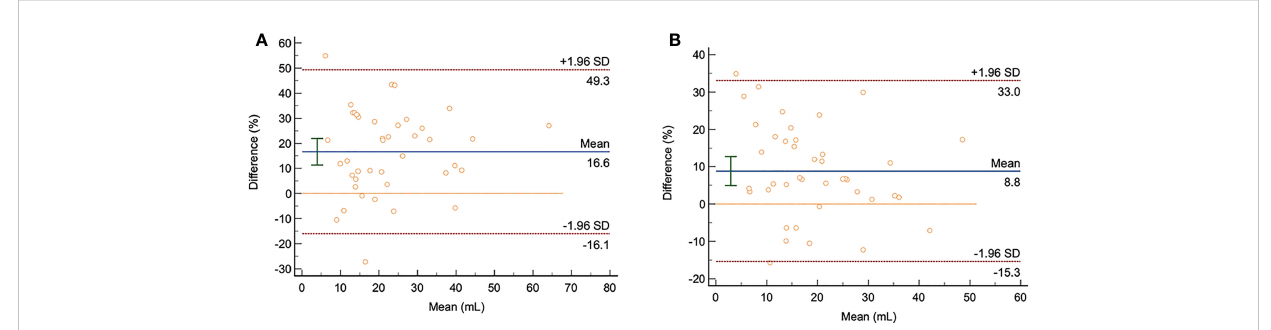
FIGURE 3 The Bland-Altman analysis chart of the semi-automatic and manual delineation for measuring GTV on the DWI images with b= 1000 s/mm 2 and b= 1500 s/mm 2 (n=41). (A, B) : The consistency analysis of GTV measurement by radiologist 1 using manual delineation and semi-automatic delineation with 30% as thresholds on the DWI images with b= 1000 s/mm2 and b= 1500 s/mm2. The averaged difference was 16.6 and 8.8; the 95% LOA were -16.1~49.3 and 15.3~33,